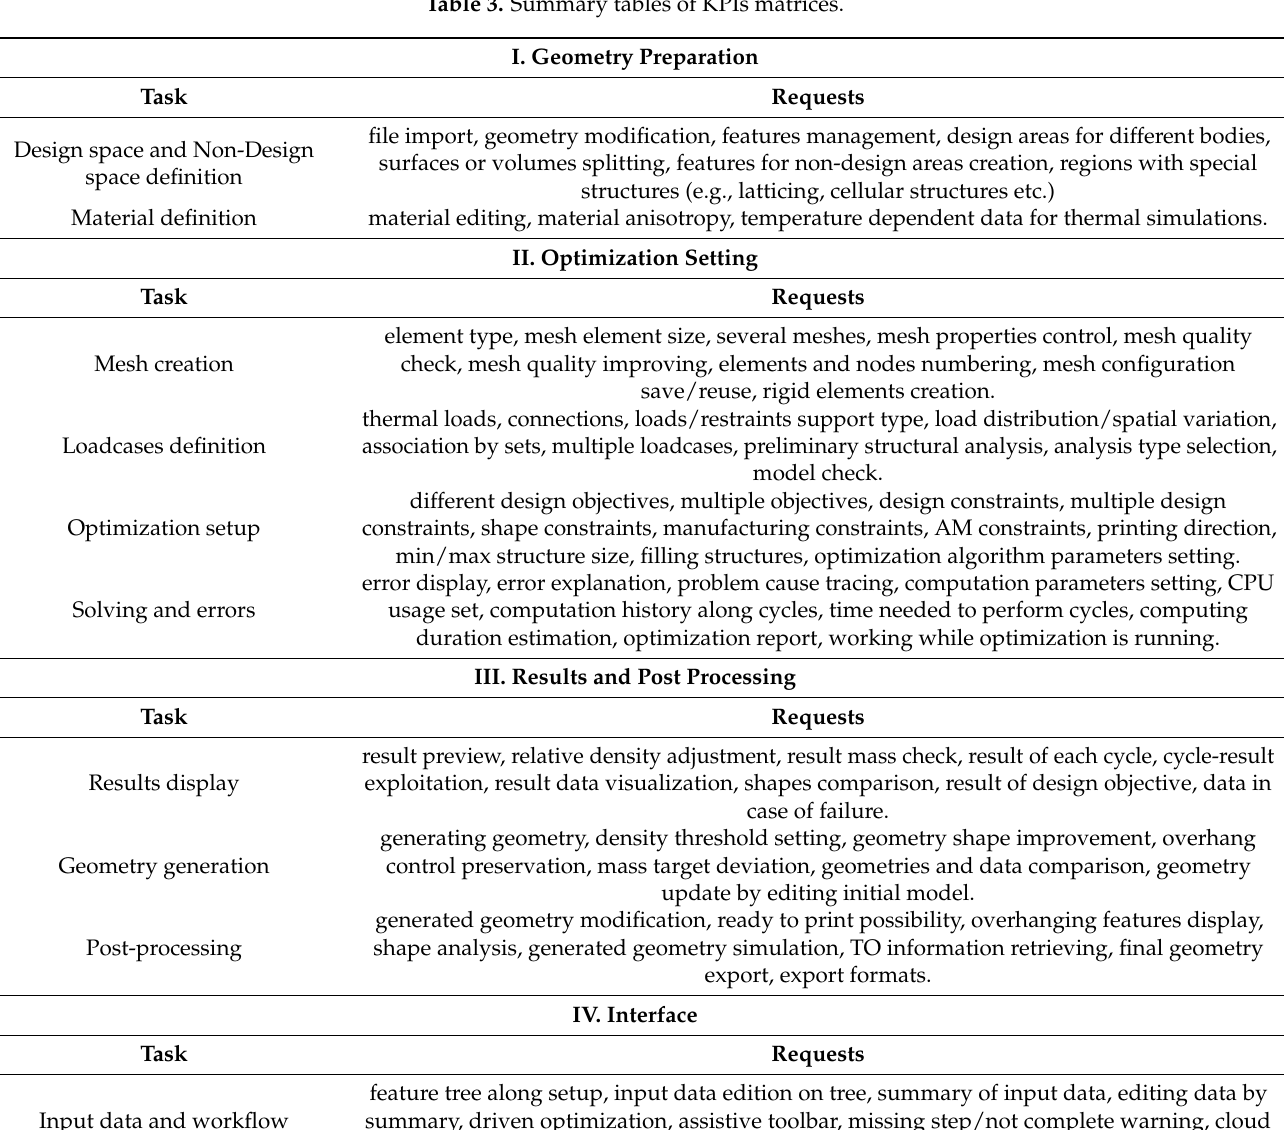
Table 3. Summary tables of KPIs